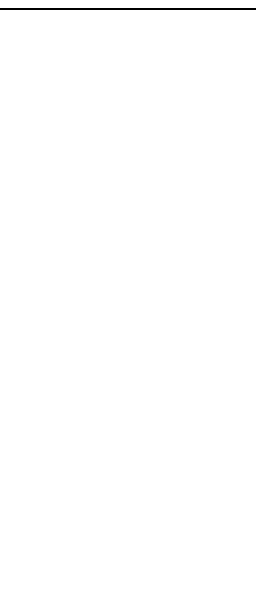
Table 2. Overview of Sustainable Development Goals (SDGs) 3, 6, 11, 13, and 17 and targets related to preventing water-borne diseases (WBDs) impacted by climate change.